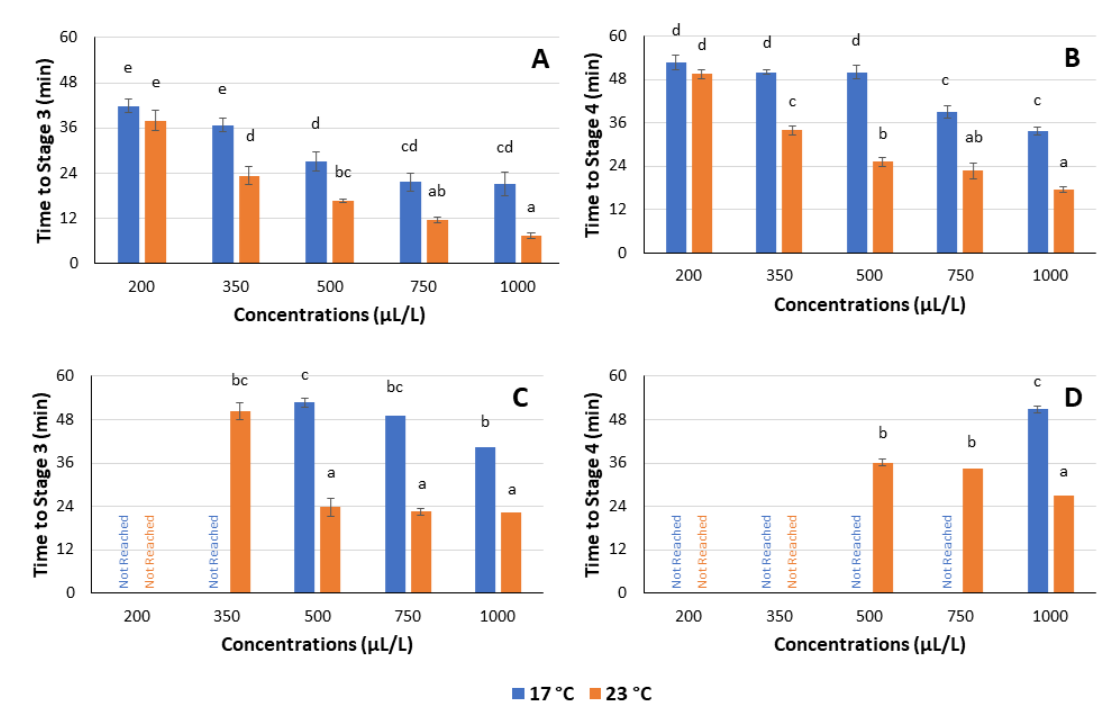
Figure 2. Times to Stages 3 and 4 inductions (min) of clove and spearmint essential oils used as a natural anesthetic for red swamp crayfish. (A) and (B) Clove oil; (C) and (D) spearmint oil. The significances between the concentrations were analyzed using one-way ANOVA. Different letters in each graphic indicate the statistical differences between the concentrations for both temperatures ( p <